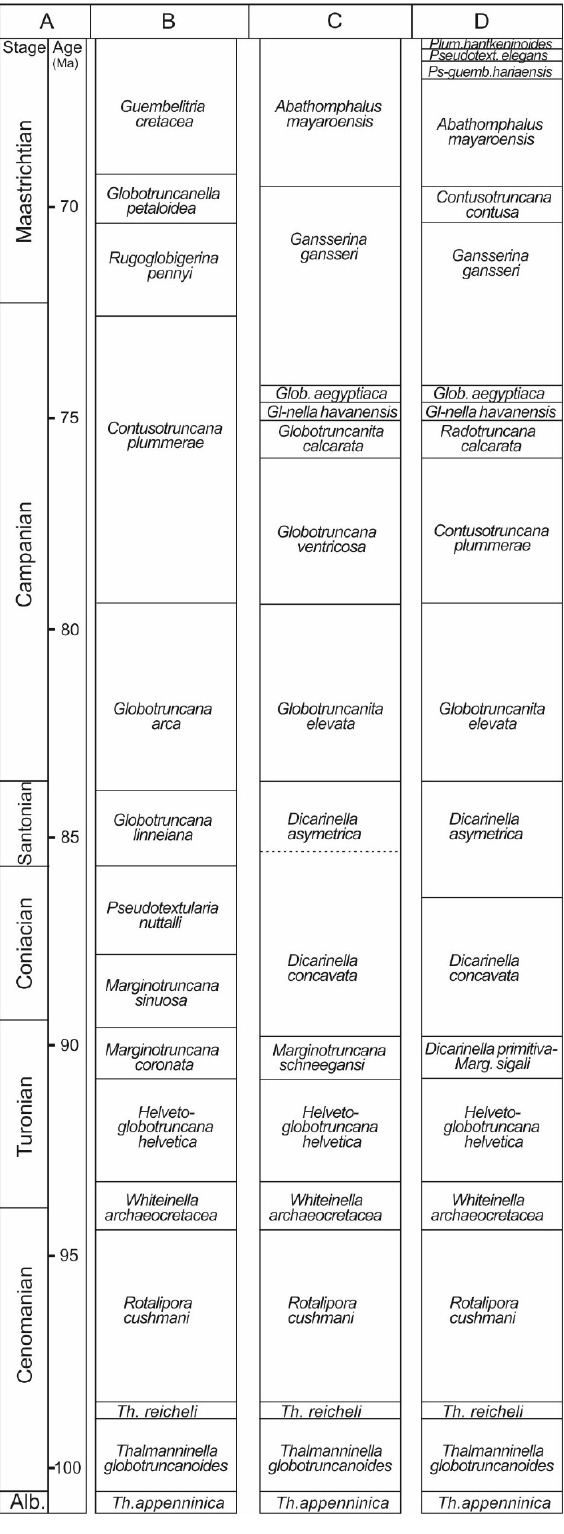
Figure 4. Correlation of the proposed zonation with the standard planktonic foraminiferal zonations [3,4] based on Tethyan species; ( A )— stages and ages after [48]; ( B )— planktonic foraminiferal zonation (this paper); ( C , D )—standard planktonic foraminiferal zonations: ( C )— after [3]; ( D )—after [4]. Genera abbreviations: Th.—Thalmanninella ; Marg.—Marginotruncana ; Glob.— Globotruncana ; Gl-nella—Globotruncanella ; Ps-guemb.—Pseudoguembelina ; Pseudotext.—Pseudotextularia ; Plum.—Plummerita